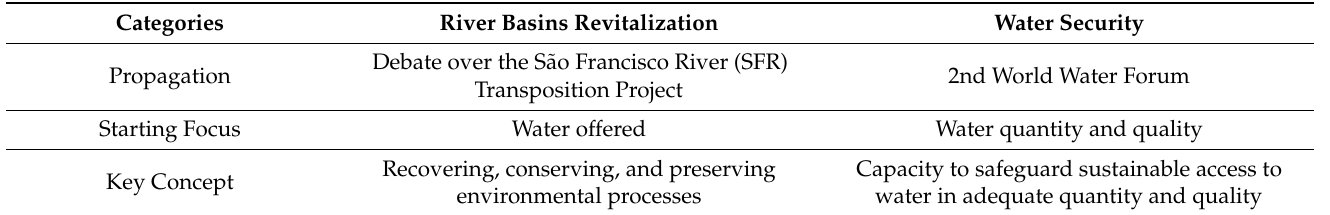
Table 3. Comparison elements between river basin revitalization and water security.